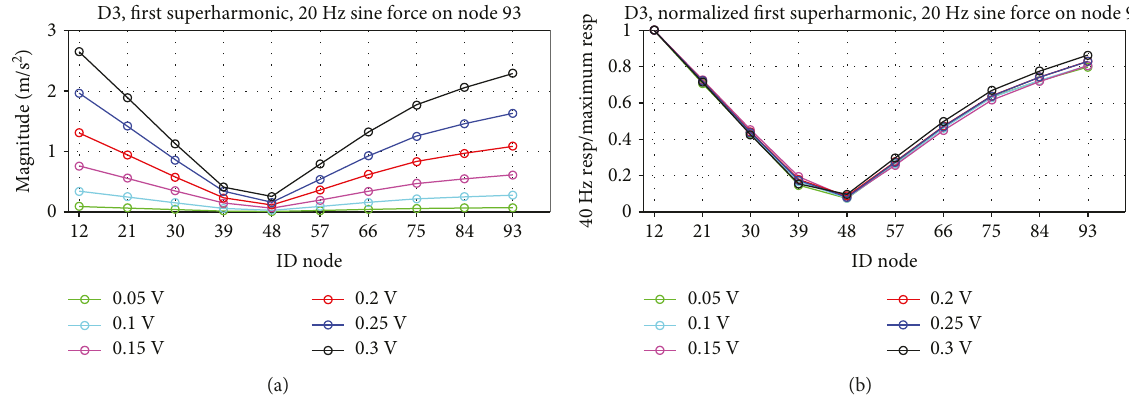
Figure 50: 40 Hz FFT magnitudes, 20Hz sine excitation force applied to node 93, D3